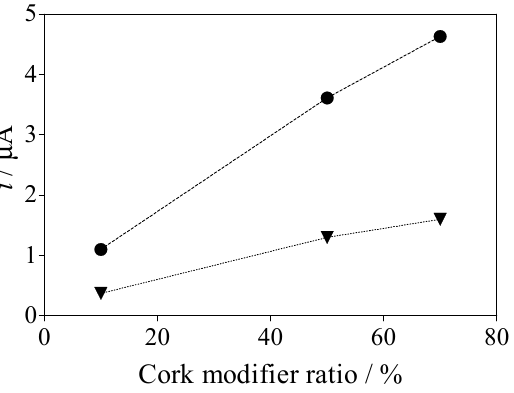
Figure 5. Anodic peak current vs. composition of ( ● ) GrRAC and ( ▼ ) GrRGC, in the presence of 0.01M caffeine in 0.5 M H 2 SO 4 solution (scan rate of 100 mV s − 1 ). On the other hand, CV curves in a non-faradaic potential range were recorded at different scan rates (0.02, 0.04, 0.06, 0.08, 0.10, 0.12, 0.14, 0.16, 0.18 and 0.20 V s − 1 ) to estimate the electro-active surface of GrRAC and GrRGC. By plotting the current, measured in the middle of the double-layer region and recorded at different scan rates, versus the scan rate, a straight line was obtained, which allowed determining the double layer capacitance values for all sensors (see Table 1). Then, using Equation (1), the geometric area of the electrodes ( ≈ 0.45 mm 2 ) and the C DL values just obtained, the real surface areas were estimated, obtaining, respectively, 0.83, 0.12 and 0.03 mm 2 for Gr, GrRAC and GrRGC. It is important to remember that the current methods used to determine experimentally the real surface area are hydrogen adsorption, double layer capacitance, surface oxide reduction, underpotential deposition of metals and adsorbed carbon monoxide stripping [30]. For the case of cork-graphite electrodes, the first three approaches could be applied efficiently; however, the double layer capacitance method allows for true surface measurements, avoiding polarization of the electrode to values that can lead to surface state changes (this is what happens in the case of oxygen evolution, formation/reduction of oxides and deposition/dissolution of metals). The double layer capacitance also allows measuring the total surface area accessible to the solution and is not destructive. Another feature to consider is that the modifier increases the porous properties of the material; for this reason, based on existing literature data [29], a reference value for porous materials should be considered to estimate the electroactive surface area, regardless of its composition. Considering the geometric surface and the estimated electroactive area of each of the electrodes (RF = A real /A geometric ), the roughness factor (RF) was determined. A high RF ( ≈ 1.85) was estimated for the Gr electrode, while lower RF values were obtained for GrRAC ( ≈ 0.26) and GrRGC ( ≈ 0.07). Thus, it was possible to understand that the electrode surface and their composition, as well as the density of electronic states of electrode materials, influence the voltammetric responses obtained during the oxidation of caffeine (see Figure 3). Although Gr showed the highest RF value, a lower current response was obtained in the presence of caffeine in solution (see Figure 3) due to the limited number of electroactive sites that allow the electron transfer process. Conversely, well-defined voltammetric responses were recorded at GrRAC and GrRGC materials, with lower background